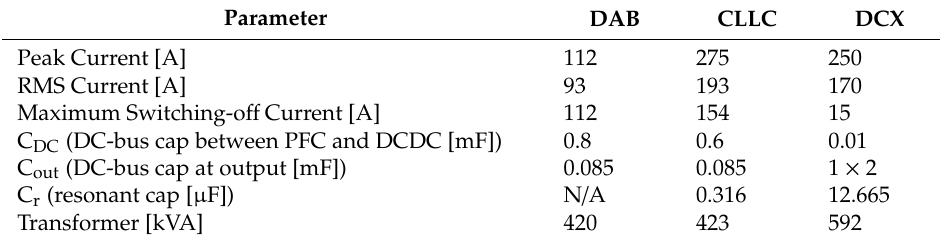
Table 2. DCX topology